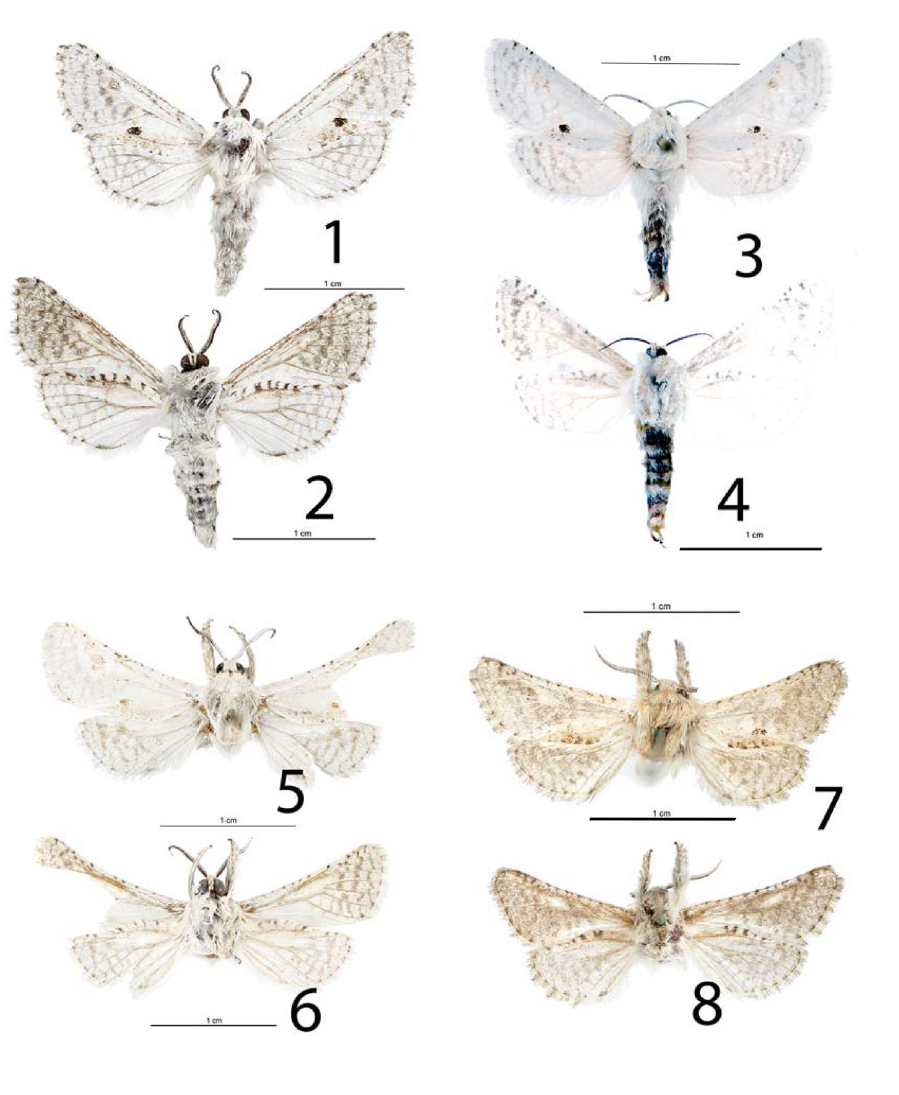
Figures 1–8. Givira adults. 1 G. delindae Holotype ♂ upperside 2 G. delindae Holotype ♂ underside 3 G. delindae Allotype ♀ upperside 4 G. delindae Allotype ♀ underside 5 G. carla Holotype ♂ (photo- graphed after dissection) upperside 6 G. carla Holotype ♂ underside 7 G. durangona Holotype ♂ (pho- tographed after dissection) upperside 8 G. durangona Holotype ♂ underside.